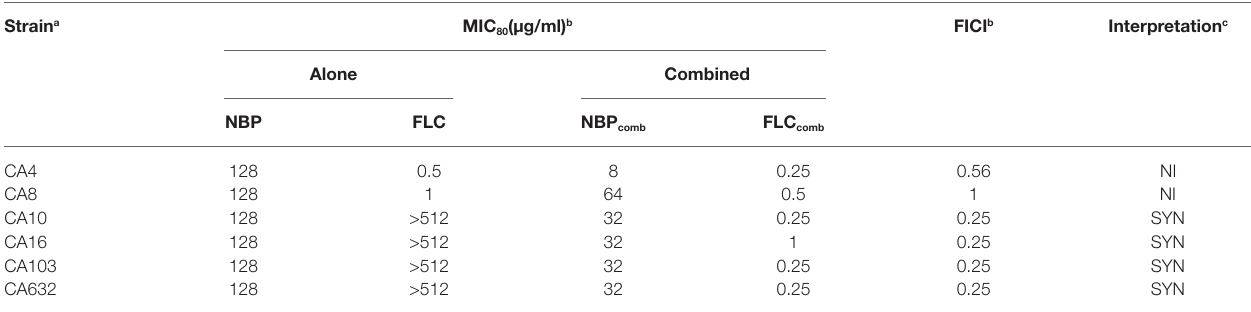
TABLE 2 | Drugs interactions of NBP and FLC against C. albicans in vitro . Strain a